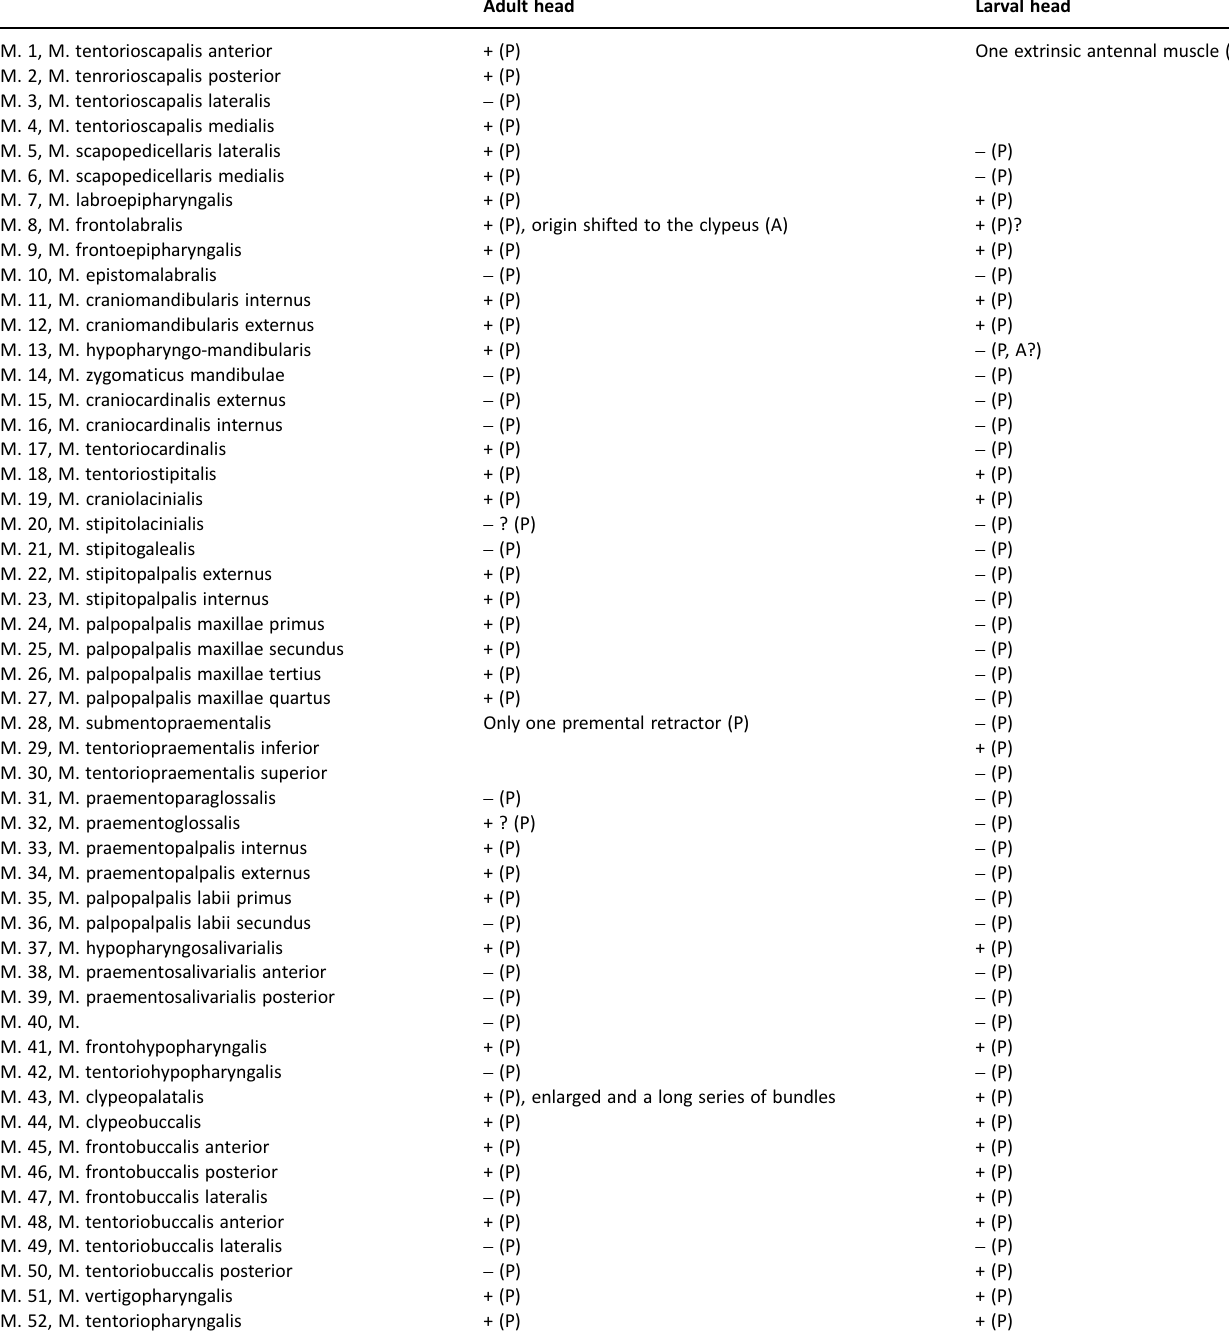
Table 4. Groundplan of the muscles of the adult and larval